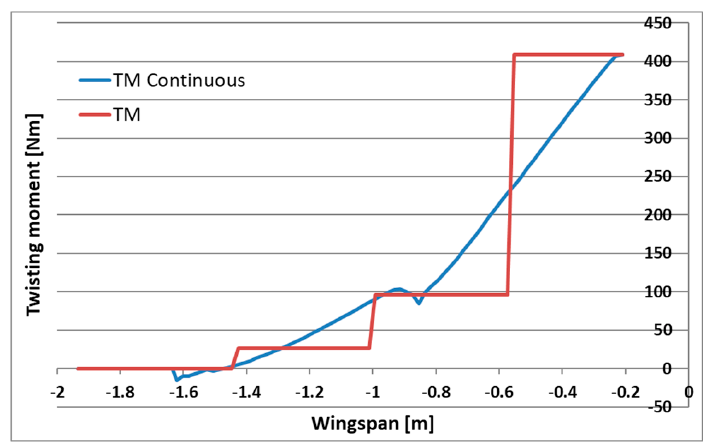
Figure 9. Twisting moment distribution for continuous and applied loading.